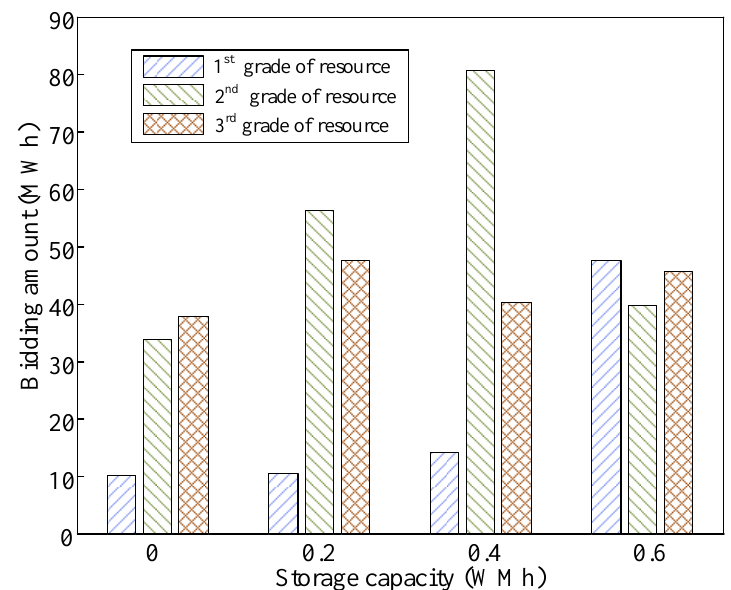
Figure 5. Bidding amount of 3 grades of DR resource for different storage